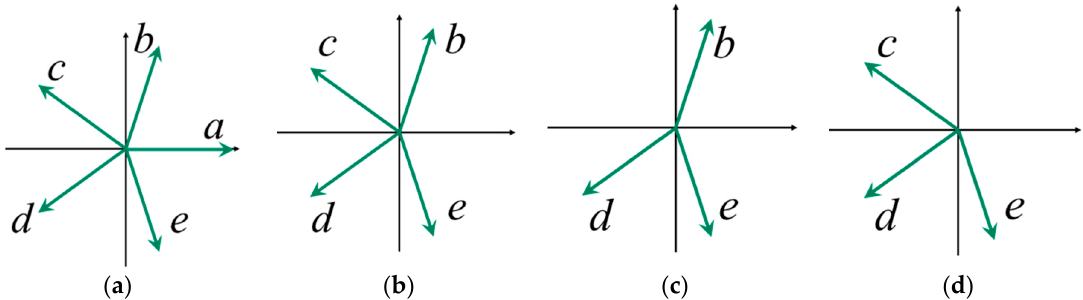
Figure 5. Vector space diagrams: ( a ) healthy operation; ( b ) phase A open; ( c ) phase A and C open; ( d ) phase A and B open.